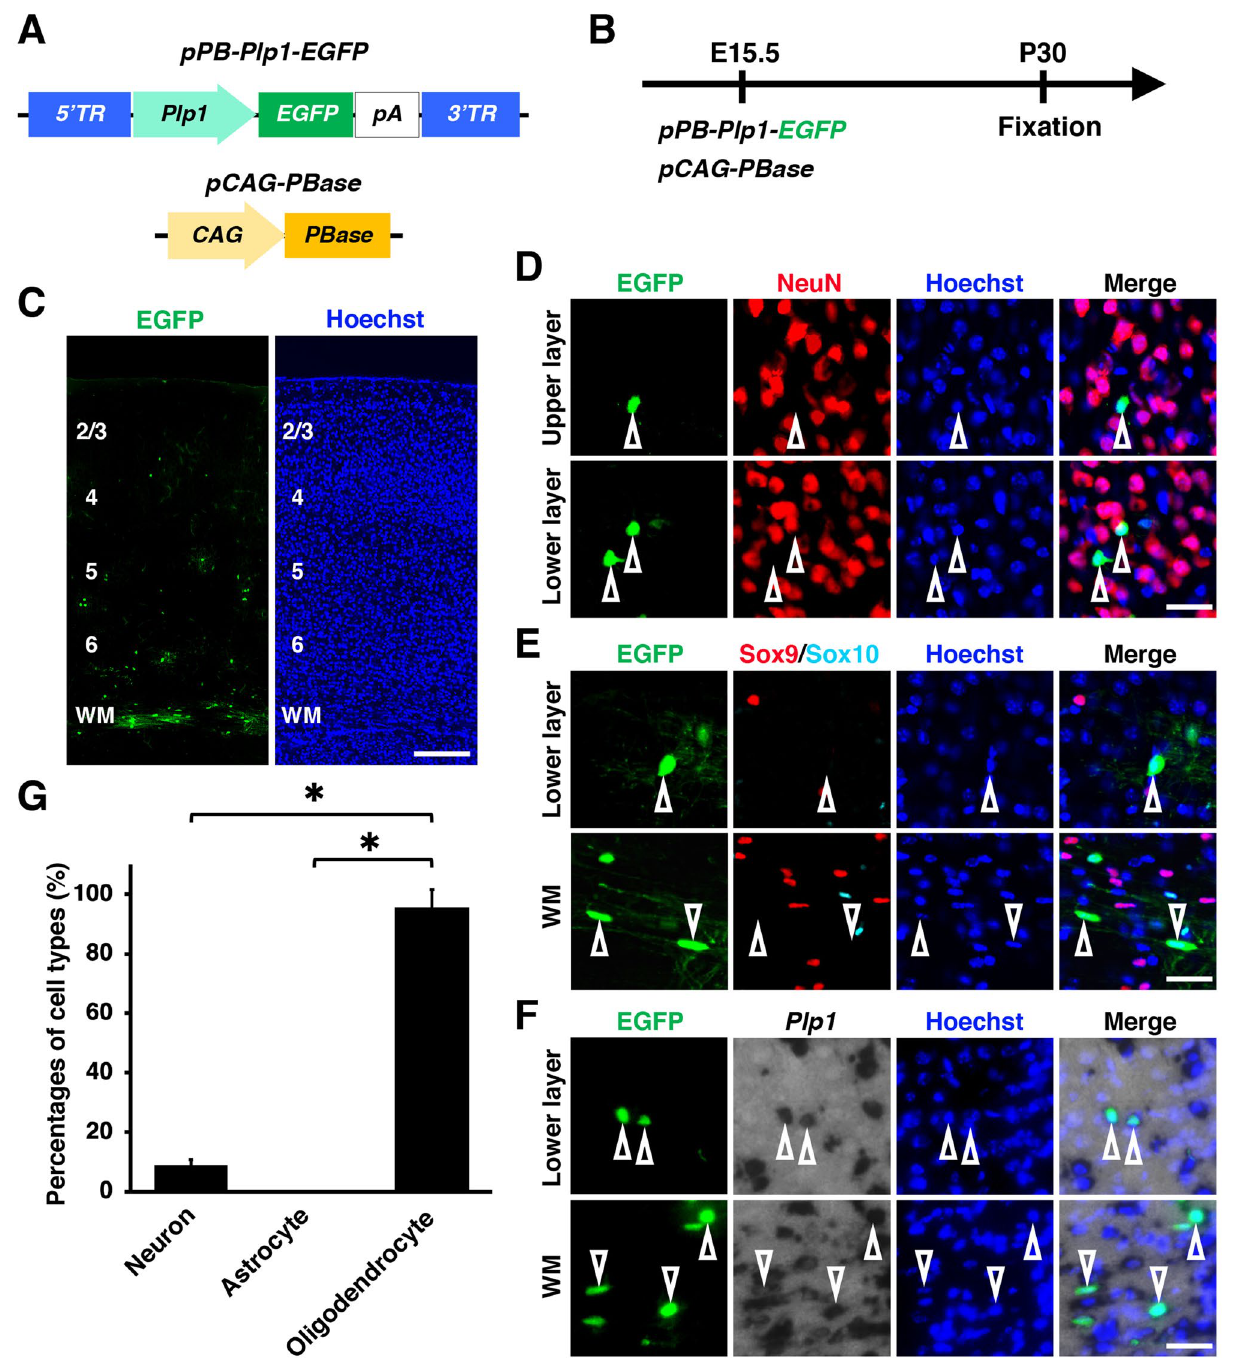
Figure 4. A Plp1 promoter induced transgene expression in oligodendrocytes specifically in the mouse cerebrum. ( A ) Schematics of pPB-Plp1-EGFP and pCAG-PBase plasmids. pPB-Plp1-EGFP drives EGFP expression under a Plp1 promoter. ( B ) Experimental procedure. pPB-Plp1-EGFP and pCAG-PBase were co-electroporated into the mouse cerebrum at E15.5, and coronal sections were prepared at P30. ( C ) Coronal sections of the electroporated cerebrum. Most EGFP-positive cells were distributed in the white matter. ( D–G ) Immunohistochemistry for NeuN ( D ), Sox9 and Sox10 ( E ), and in situ hybridization for Plp1 ( F ). Most EGFP- positive cells were positive for Plp1 and negative for NeuN and Sox9 (open arrowheads). ( G ) The percentages of EGFP-positive cells which are also NeuN-positive (neuron), Sox9-positive/Sox10-negative (astrocyte) or Plp1 -positive (oligodendrocyte). This Plp1 promoter drove gene expression in oligodendrocytes selectively when combined with the piggyBac system and in utero electroporation. Unpaired Student’s t -test, * P < 0.00005. Error bars represent mean ± SD. The statistical analyses were performed using Microsoft Excel ver. 16.43. Scale bars: 200 μm ( C ), 30 μm ( D-F ). TR, terminal region; WM, white matter. Numbers indicate layers in the cerebral